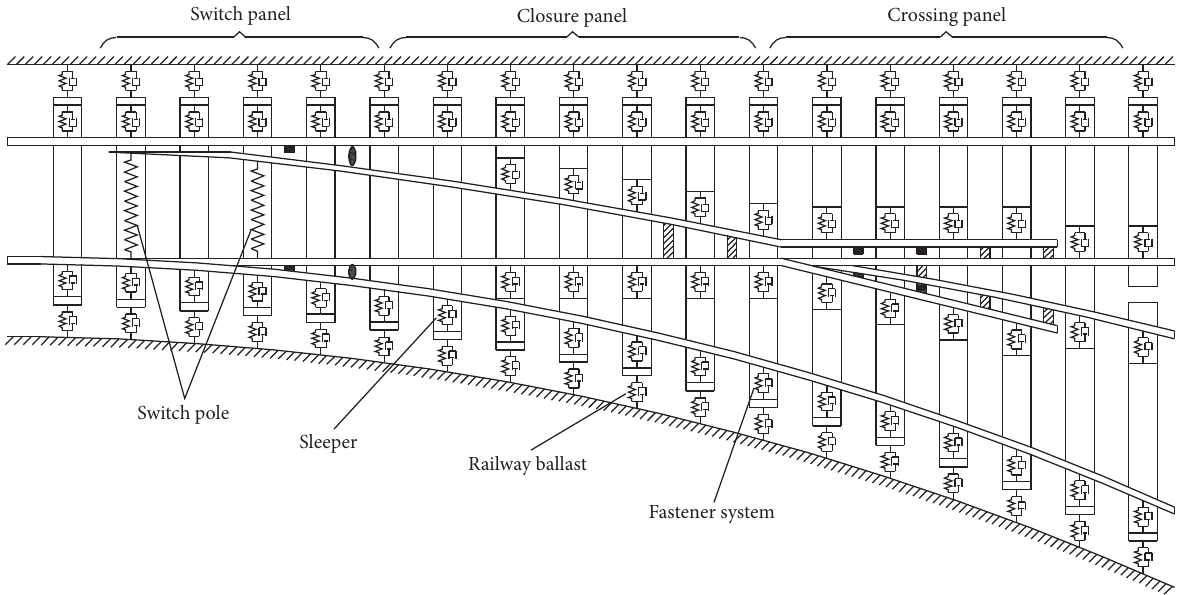
Figure 7: Dynamic model of a high-speed railway turnout.